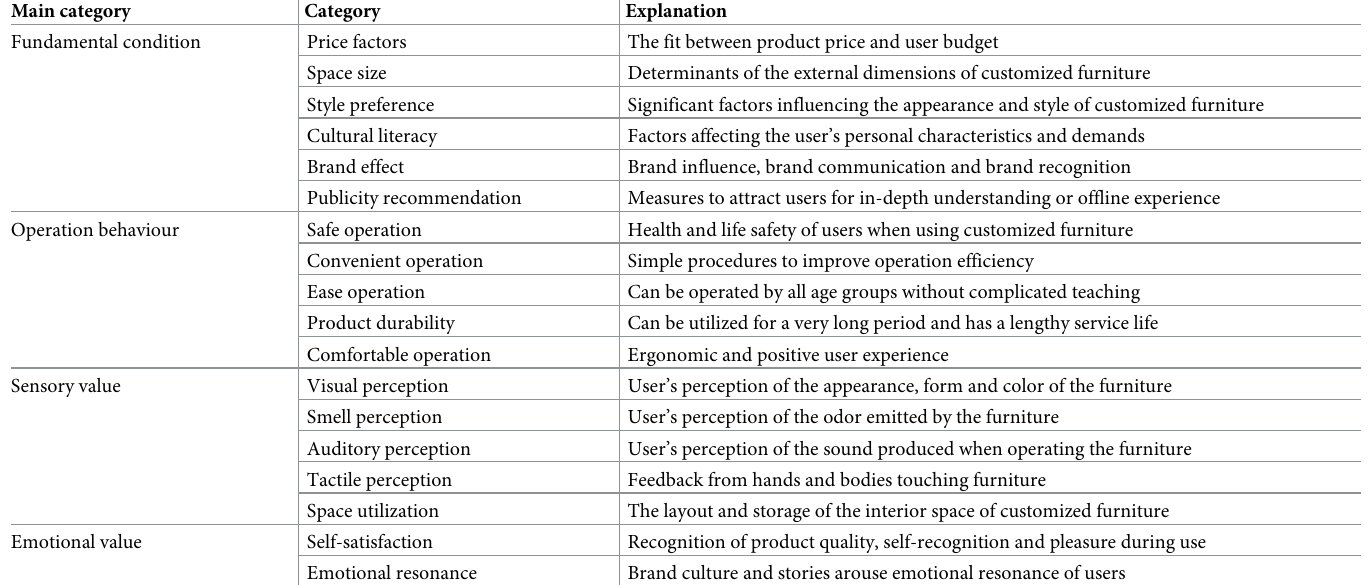
Table 3. Partial axial coding process.